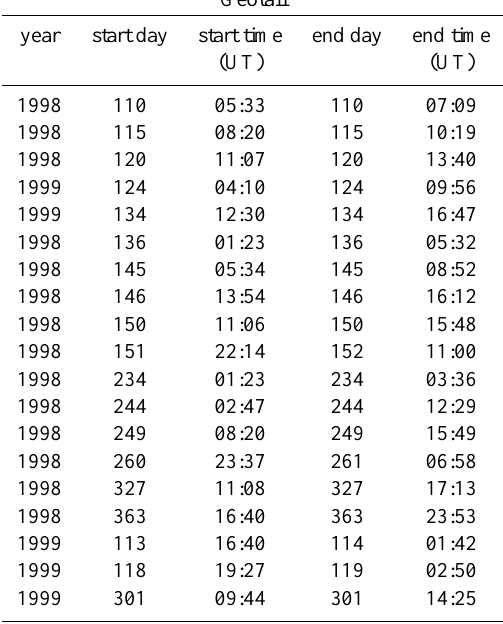
Table 1. Magnetopause-crossing intervals from the Interball-Tail spacecraft.